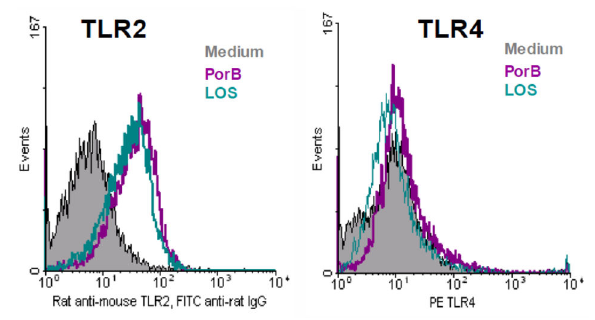
Figure 3. PorB increases surface expression of TLR2. C57Bl/6 mouse BMDM were stimulated with PorB or LOS. Stimulation lead to increased surface expression of TLR2 following stimulation with either TLR ligand when compared to media controls. Neither ligand, however, induced surface expression of TLR4. Histograms are from one representative sample of at least 3. Data represents one of two